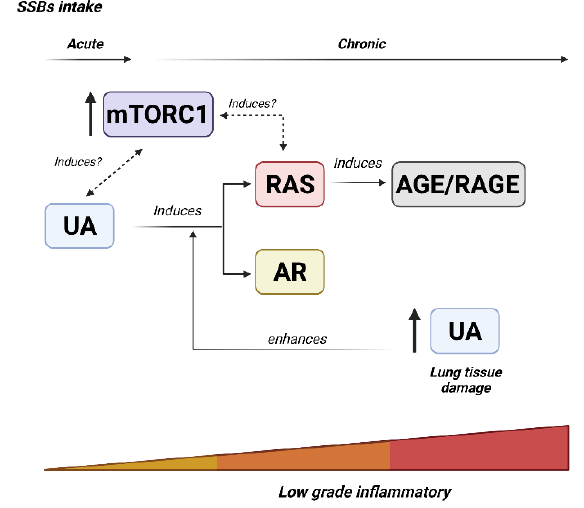
Figure 3. Proposed low-grade inflammatory mechanisms related to lung damage induced by SSBs intake. High intake of fructose induces many low-grade inflammatory mechanisms that may contribute to lung diseases. Firstly, excessive fructose induces cellular metabolic stress that increases UA levels. UA could be an effector mechanism that triggers inflammatory response through inflam- matory pathways, such as the RAS system, AR activity, and mTORC1. Secondly, chronic exposure to fructose modifies proteins (Fru-AGEs) that sustain the inflammatory state. Finally, a deleterious feedback loop sustains and may explain chronic endothelial and epithelial dysfunction, and chronic low-grade inflammation related to lung damage and dysfunction.